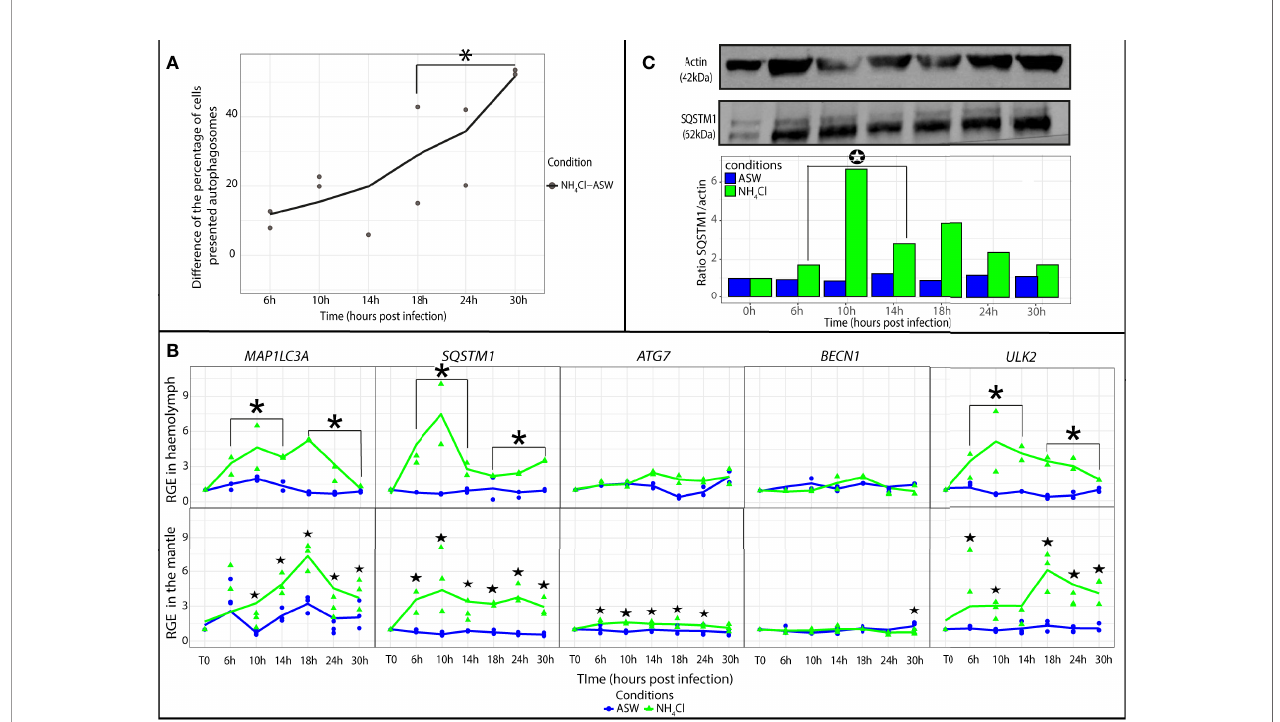
FIGURE 4 | Modulation of autophagy in Crassostrea gigas exposed to NH 4 Cl. (A) Monitoring of autophagy in haemocytes of C. gigas by fl ow cytometry. Scatterplot of the difference of the percentage of haemocytes presented autophagosomes between the seawater condition (ASW) and the NH 4 Cl condition from 6 to 30 hpi (n=2 pools of 15 animals). The line represents the trend curve of the difference of percentage of cells between the two conditions. *Signi fi cant increase of the difference of the percentage of cells presented autophagosomes between the NH 4 Cl and ASW condition between 18 to 30hpi (p < 0.05). (B) Relative gene expression of key autophagy genes in haemolymph and the mantle of the Paci fi c oysters, C. gigas , in ASW condition (blue) and NH 4 Cl condition (green) at each sampling time point (T0, 6, 10, 14, 18, 24 and 30 hpi) detected by real time PCR (haemolymph: n=2 pools of 15 animals; mantle: n=3 animals). The line represents the trend curve of the expression of each gene in the NH 4 Cl condition (green) and the ASW condition (blue). Signi fi cant difference between the NH 4 Cl and ASW conditions at early (6-14 hpi) or late time points (18-30 hpi) of the experimental infection (p < 0.05). Signi fi cant difference between the NH 4 Cl and ASW conditions of the same time point (p < 0.05). RGE, relative gene expression. (C) Detection of the autophagy protein SQSTM1 in the mantle of C. gigas during the kinetic of exposition to NH 4 Cl at each sampling time point (for each time point n=1 pool of 3 animals). Signi fi cant differences between the NH 4 Cl and ASW condition at early (6-14 hpi) or late time points (18-30 hpi) of the experimental infection (p <